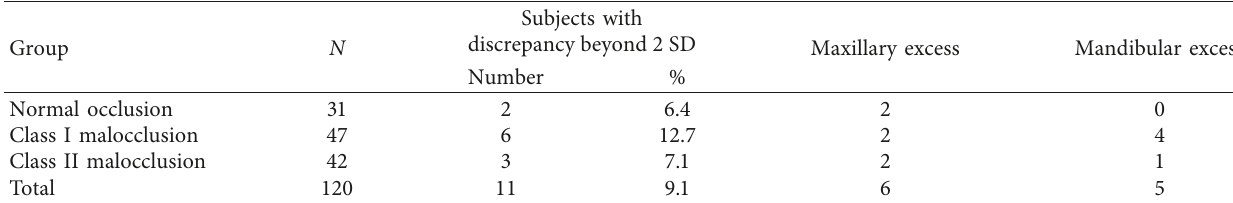
Table 8: Frequency of distribution of subjects with the overall ratio beyond mean ± 2 SD of Bolton’s norms (91.3 ± 1.91). Group N